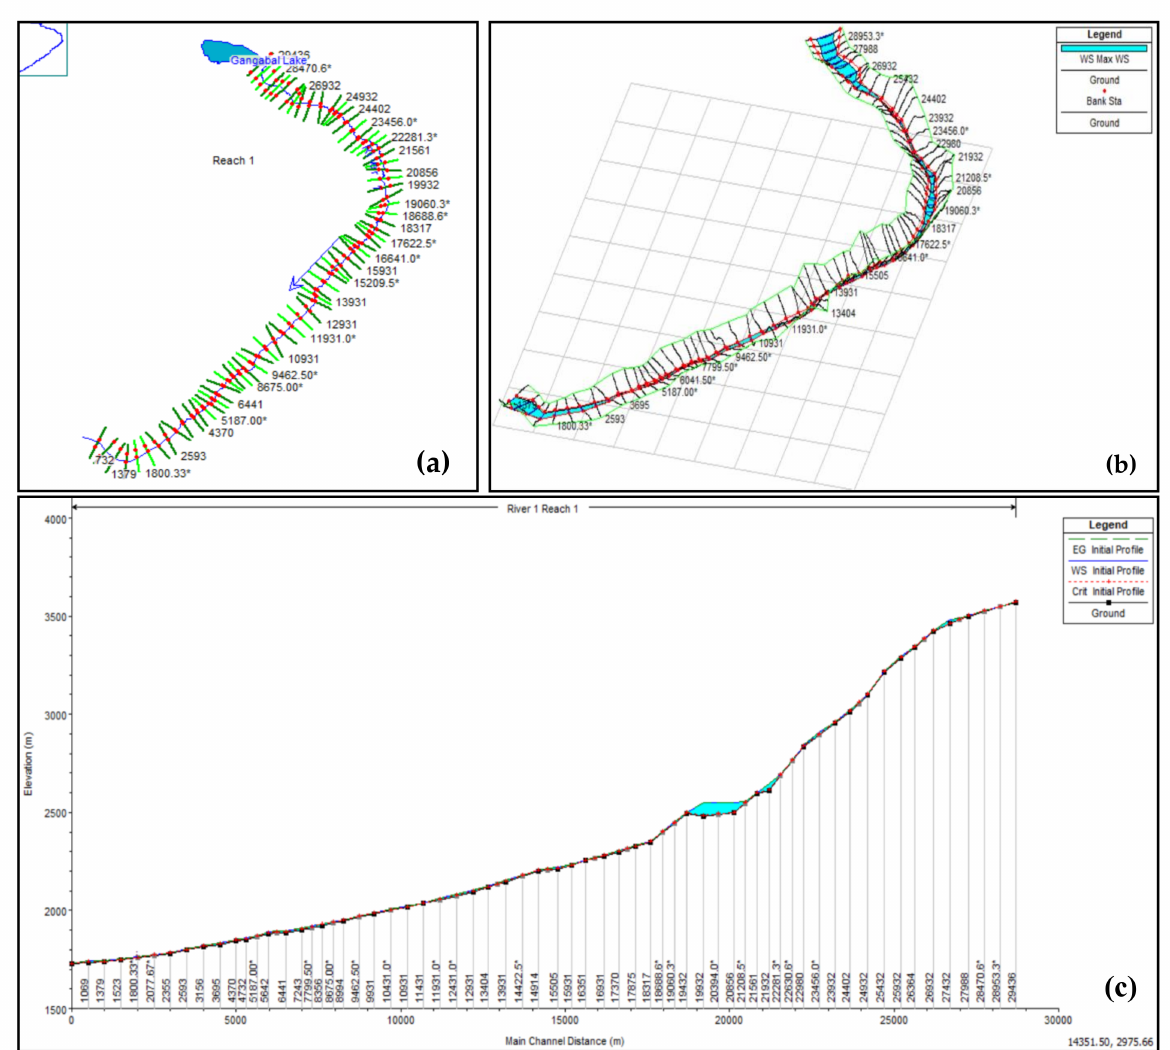
Figure 6. ( a ) Cross sections at various locations across the river channel; ( b ) XYZ perspective plot of the river channel; and ( c ) river bed profile depicting distance with respect to the elevation of the river channel. * XS